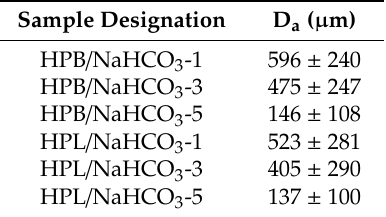
Figure 6. Pore surface area distribution and a representative cross-sectional micrograph for the formulations comprising hydrophilic thermoplastic polyurethane (HPL) and ( a ) 1%, ( b ) 3% and ( c ) 5% NaHCO 3 . Table 2. Average circle equivalent pore diameter (D a ) of the porous extrudates comprising hydrophobic (HPB), hydrophilic thermoplastic polyurethane (HPL) and NaHCO 3 as the pore former. Sample Designation